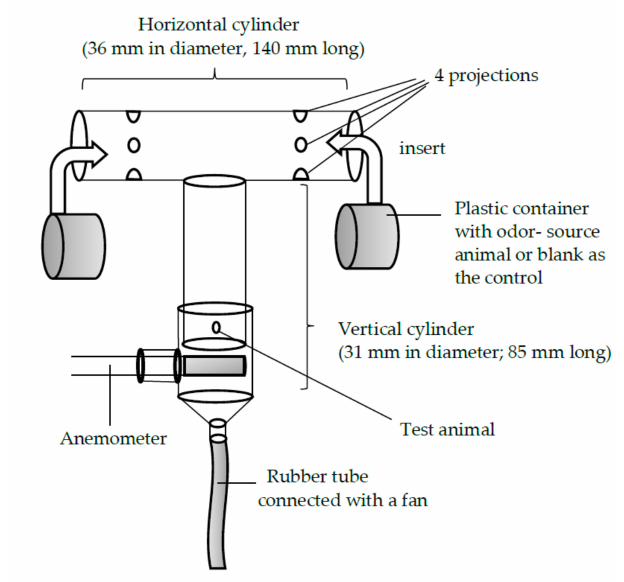
Figure 1. The T-shaped glass olfactometer used in the experiment with Rosalia batesi . Of the two arms, the one that the test animal selected was